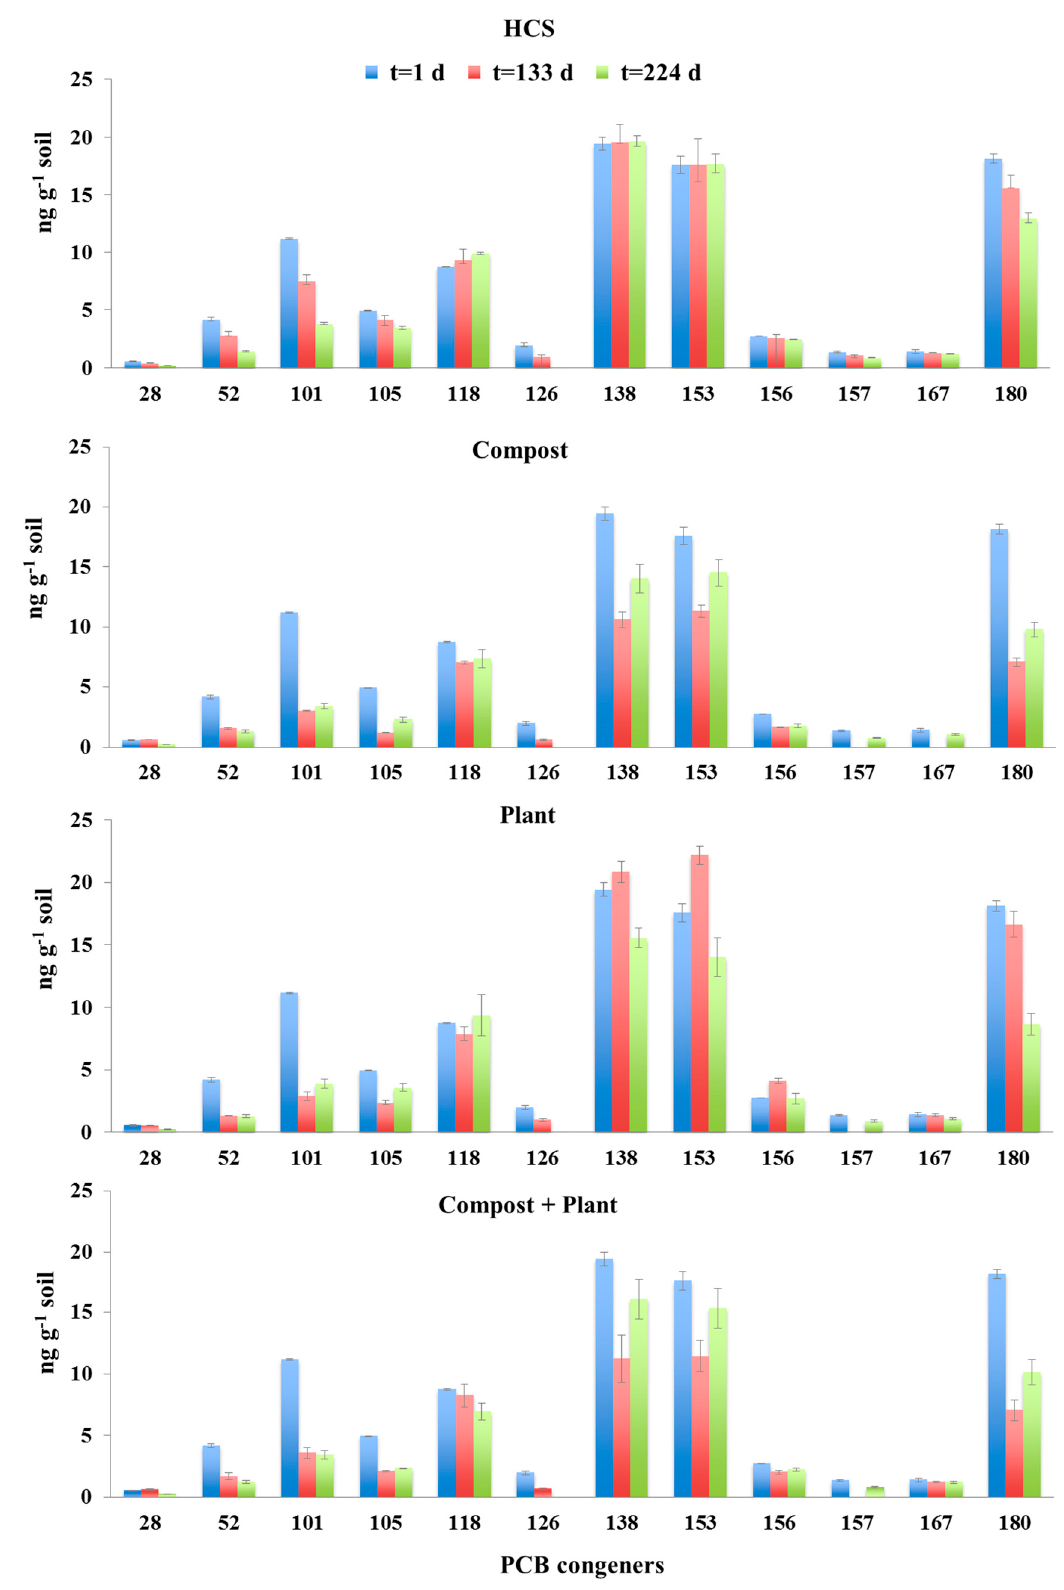
Figure 2. PCB congeners (ng g − 1 soil) analysed at different times (1, 133 and 224 d) in the soil microcosms. HCS: historically contaminated soil; Compost: historically contaminated soil amended with municipal solid waste compost; Plant: historically contaminated soil with Medicago sativa plant; Compost + Plant: historically contaminated soil amended with the compost, in the presence of Medicago sativa plant. The vertical bars represent the standard errors.